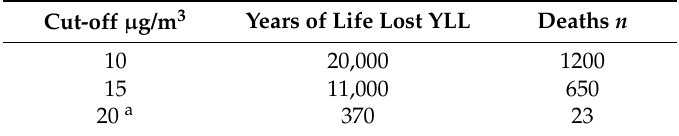
Table 7. Mortality impacts of nitrogen dioxide at different cut-off levels and RR =